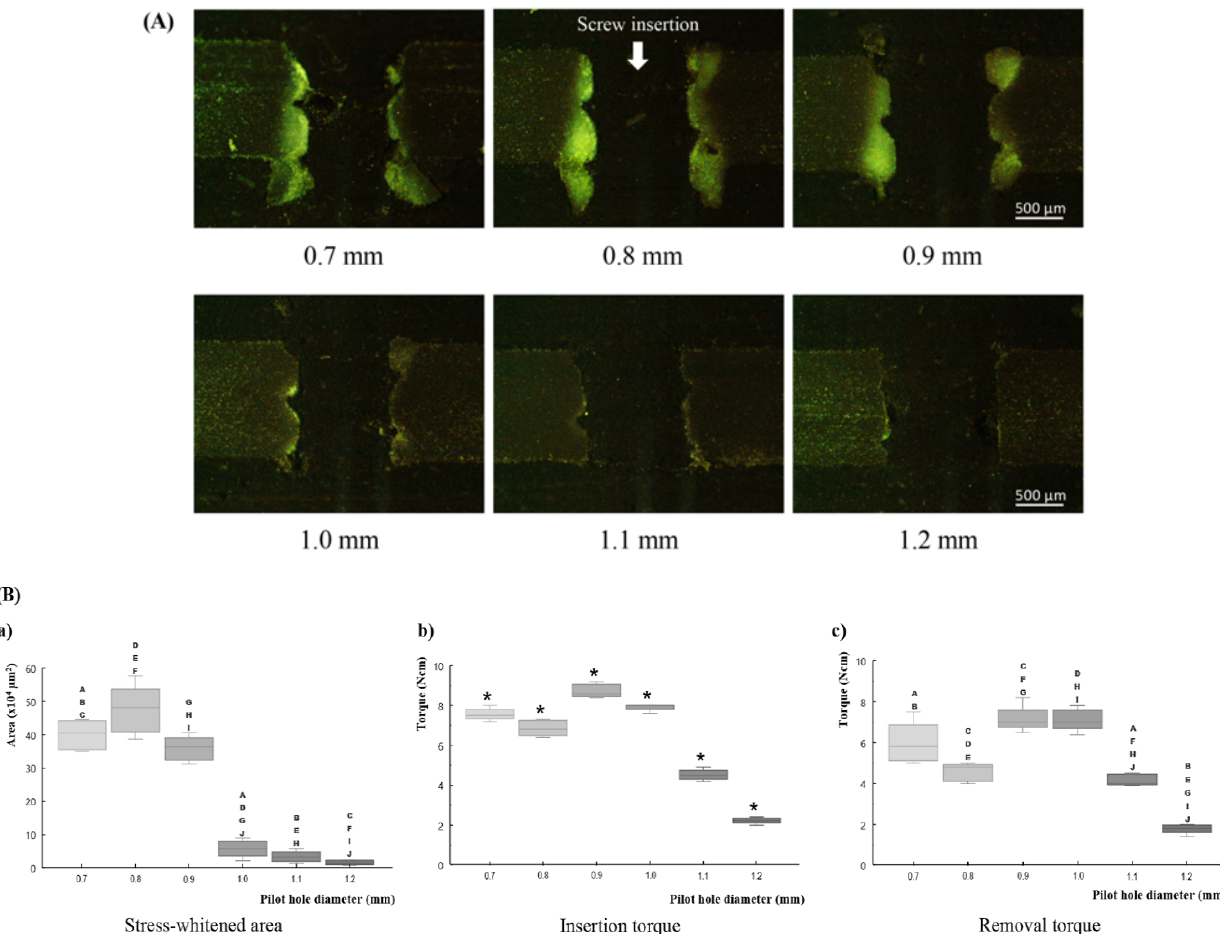
Figure 4. Results of miniscrew insertion test. ( A ) light microscopic images of the tested bone pieces in cross-sectional view (Bar = 500 µm), ( B ) box-plot graphs showing median values. ( a ) stress-whitened area, ( b ) maximum insertion torque, and ( c ) maximum removal torque. The asterisk represents significant differences among all groups ( p < 0.05). A–J in graph ( a , c ) indicate significant differences ( p < 0.05) between respective pairs of